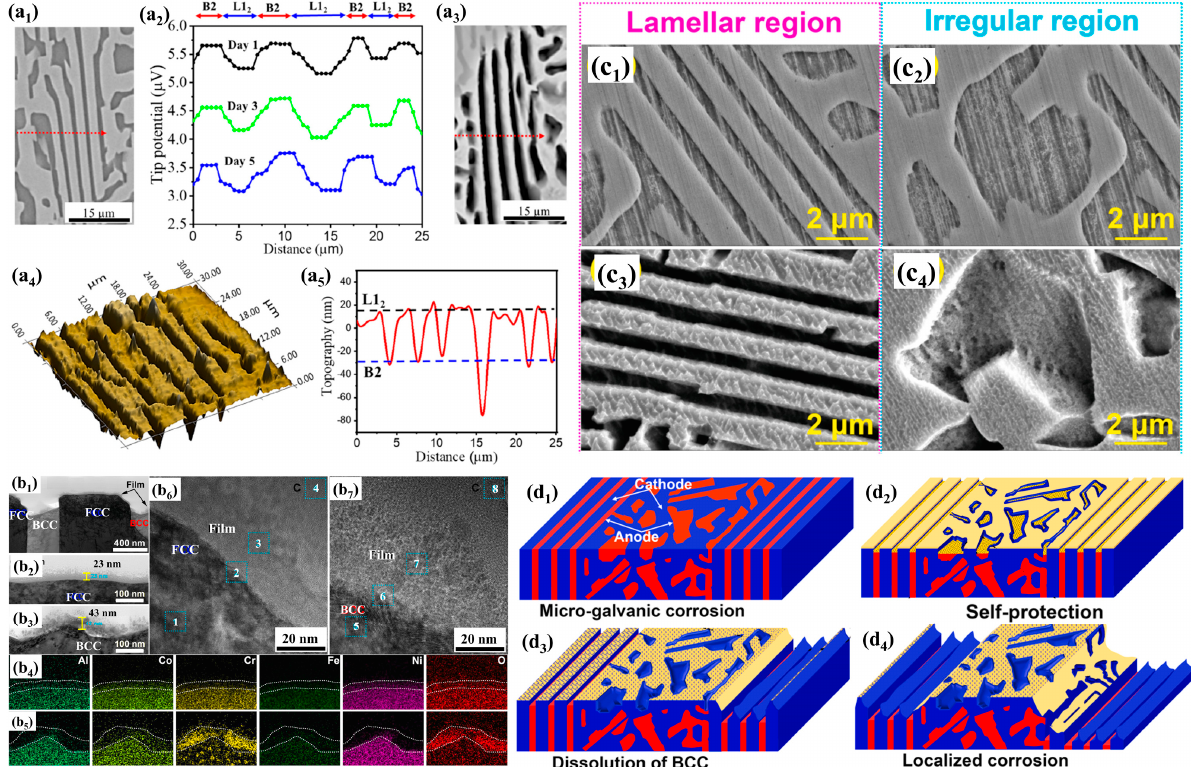
Figure 11. ( a 1 ) SEM morphology of the eutectic AlCoCrFeNi 2.1 specimen surface; ( a 2 ) line-scanning of eutectic AlCoCrFeNi 2.1 immersed in 1 wt.% NaCl aqueous solution at different time interval obtained at the dashed line; ( a 3 ) corrosion morphology of the specimen after immersion for 5 days; 3D image ( a 4 ) and line profile ( a 5 ) of the corroded specimen showing preferential dissolution of B2 phase. TEM characterizations of corrosion product film upon specimen at 2 h: ( b 1 ) BF-TEM morphology; ( b 2 , b 3 ) the magnified TEM images of films upon FCC and BCC phases; ( b 4 , b 5 ) elemental distribution of films upon FCC and BCC phases; ( b 6 , b 7 ) HRTEM images of film on FCC and BCC phase; ( c 1 – c 4 ) corrosion morphologies in different regions of EHEA in 0.5 M H 2 SO 4 aqueous solution after being immersed for different times: 5 min and 8 h. The schematic of corrosion mechanism of EHEA: ( d 1 ) micro-galvanic corrosion effect; ( d 2 ) short-term self-protection; ( d 3 ) the dissolution of surface BCC phase and the dissolution of FCC lamellas; ( d 4 ) localized dissolution of lamellar region